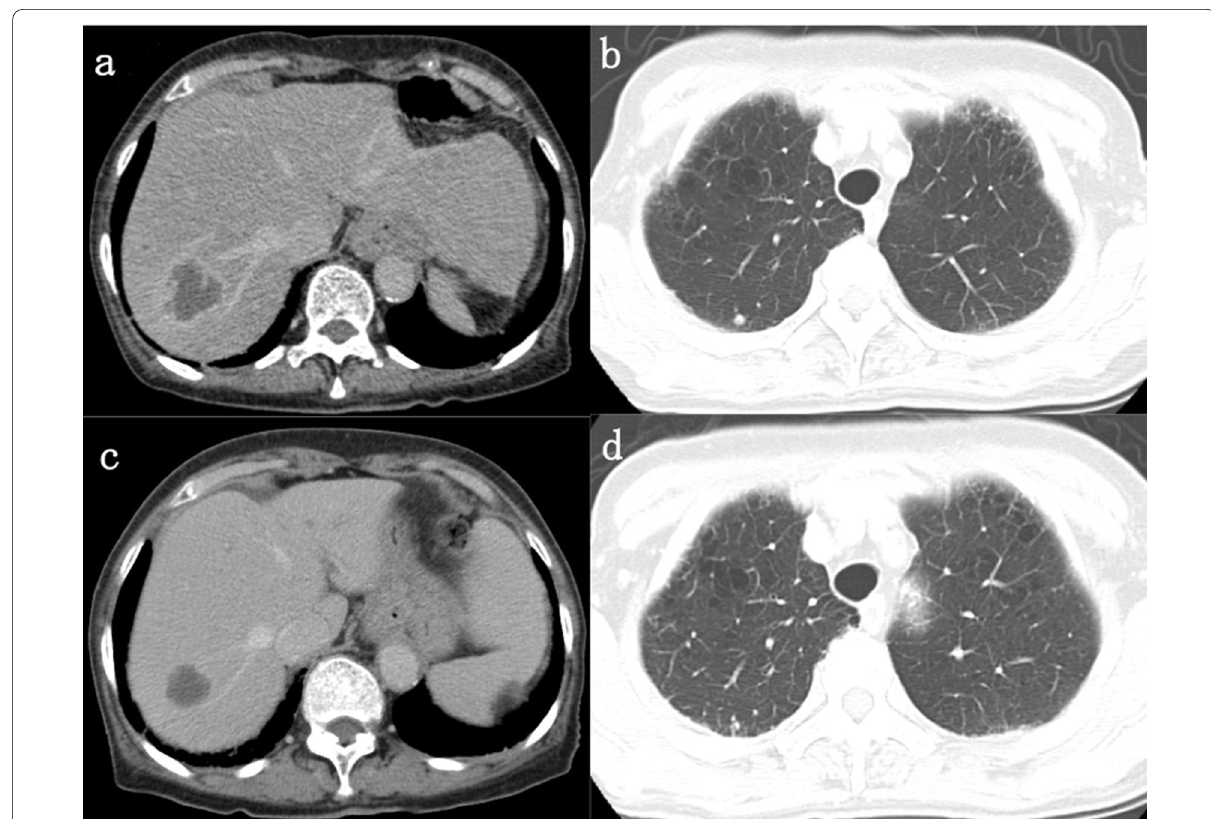
Fig. 4 Metastatic mass in the liver before and after XELOX and bevacizumab treatment ( a and c ). Metastatic nodule in the right lung before and after XELOX and bevacizumab treatment ( b and d ). XELOX